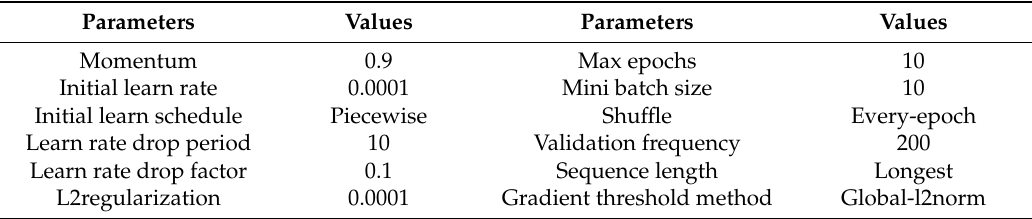
Table 3. Parameter settings of all